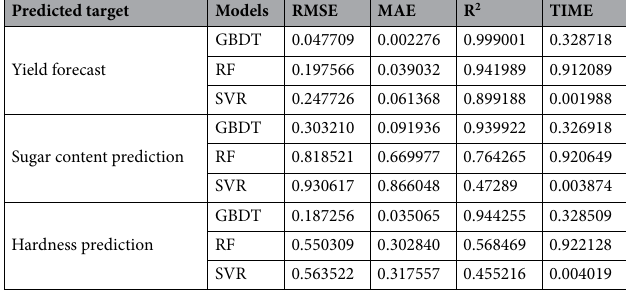
Table 3. Predictive metrics with the reduced features as inputs.